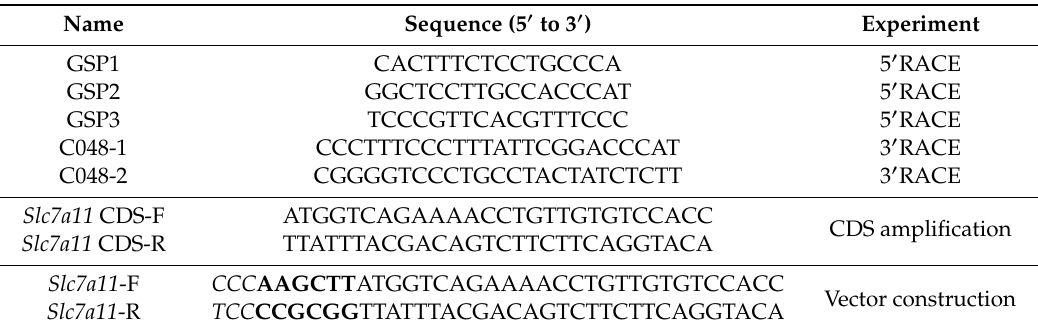
Table 1. Primers used for Slc7a11 RACE and